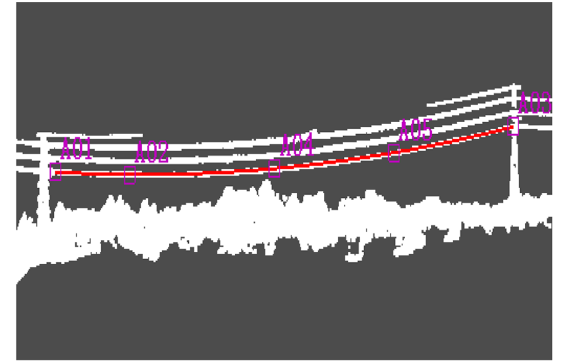
Fig. 6 Adding control points and generating power lines. The purple quadrangles represent control points and the red line represents generated line